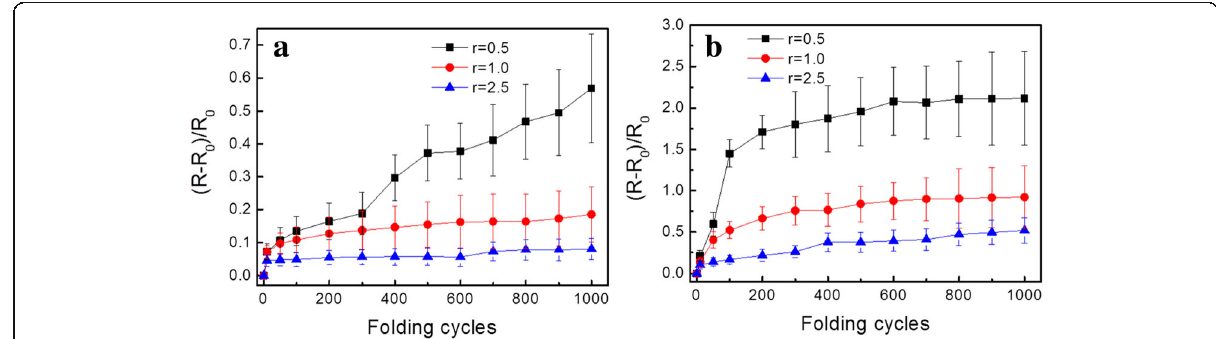
Fig. 7 Electrical resistance change rate, ( R − R 0 )/ R 0 , as a function of bend radius ( r ) and number of bend cycles on a art coated paper